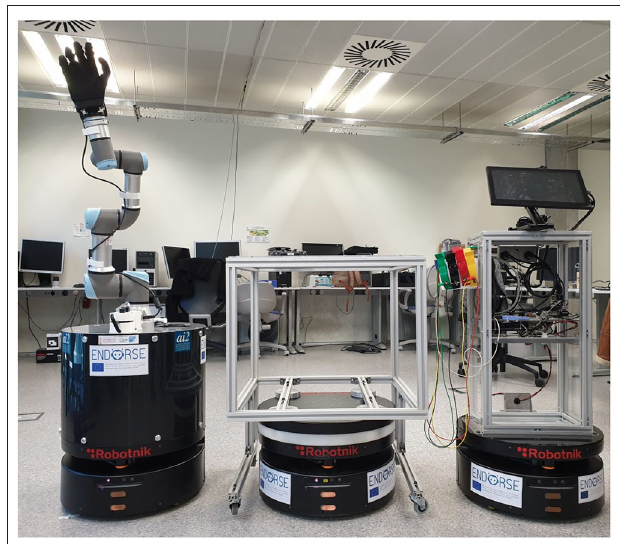
FIGURE 1 | ENDORSE project proof-of-concept mobile robotic fleet [http:// www.endorse-project.eu/]. Robotnik’s RB-1 robot is used with different, easily swappable, and mountable hardware modules. From left to right, a robotic arm (Universitat Politecnica de Valencia, Spain), a carrier component for logistic tasks (Robotnik, Spain), and an e-diagnostic module for vital signs acquisition (StreamVision, France) and communication to a cloud-based electronic health record (EHR) system (University of Cyprus,